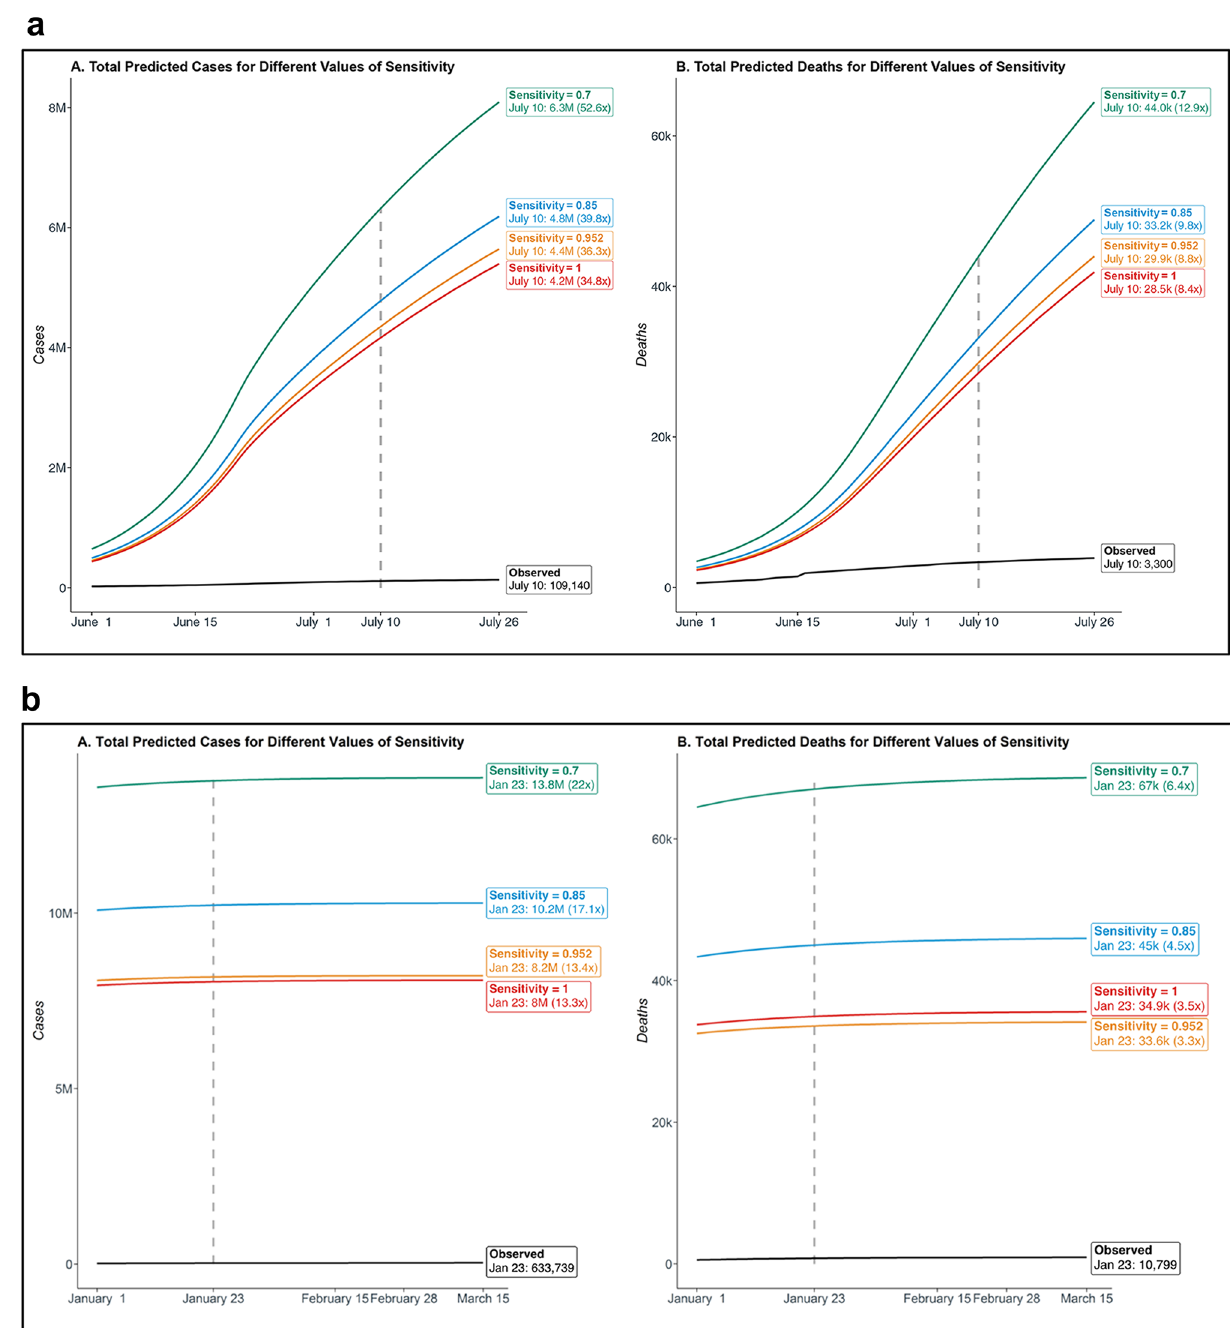
Figure 3. Summary of cumulative total (reported and unreported) cases and deaths for four different assumed values of sensitivity for the diagnostic RT-PCR test: 0.7, 0.85, 0.952, 1. In each subfigure, panels A and B respectively summarize the cases and deaths, along with their reported observed counterparts. The specificity of the diagnostic test is assumed to be 1. (a) Projections based on training data during March 15 to June 30, 2020, and testing period between June 1 to July 26, 2020. (b) Projections based on training data during March 15 to December 31, 2020, and testing period between January 1 to March 15, Case fatality rate (CFR) and infection fatality rate (IFR). The sensitivity and specificity of the diagnos- tic test impact our estimate of the case-fatality rate ( # deaths # reportedcases ), but not the infection-fatality rate ( # deaths # trueinfections ). We estimate that the CFR lies between 2.24–3.06% as of July 10, 2020 (Table 2a), and between 1.40 and 1.91% as of January 23, 2021 (Table 2b). On the other hand, the sensitivity and specificity of the antibody test impact our estimates of the IFR. We estimate that the IFR lies between 0.07 and 0.08% based on the reported death counts as of July 10, 2020, and between 0.09 and 0.10% based on that as of January 23, 2021 (Table 2).